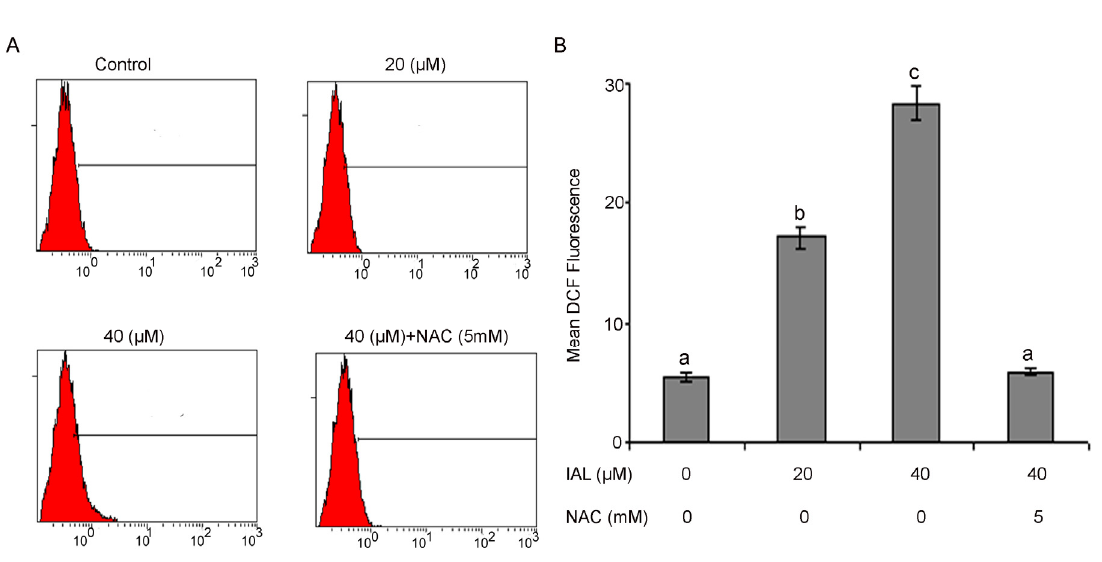
Figure 6. Flow cytometry analysis of ROS generation. ( A ) PC3 cells were treated with 20 and 40 µM isoalantolactone (IAL) in the presence or absence of 5 mM NAC for 24 h. ( B ) Data are expressed as Mean ± SD (n = 3). Columns not sharing the same superscript letter differ significantly ( p <